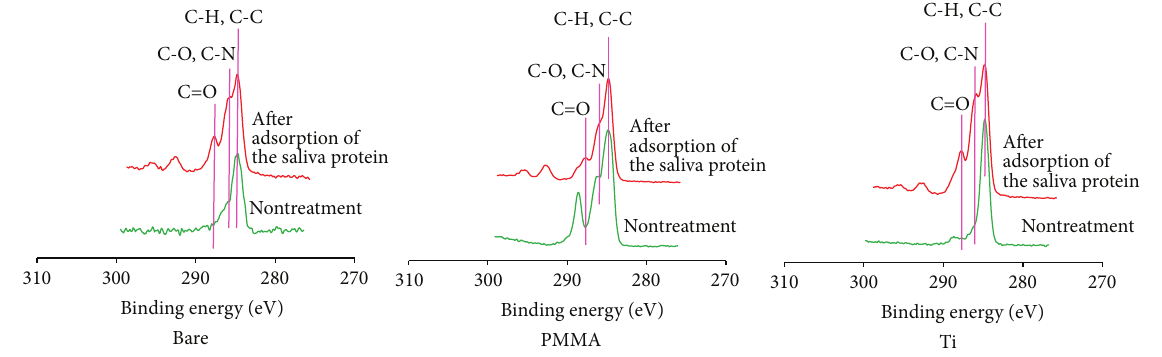
Figure 10: XPS analysis after adsorption of BSM. C1s XPS spectra for BSM adsorbed onto bare, PMMA, and Ti QCM sensors. C1s XPS spectra before (green) and after (red) adsorption for